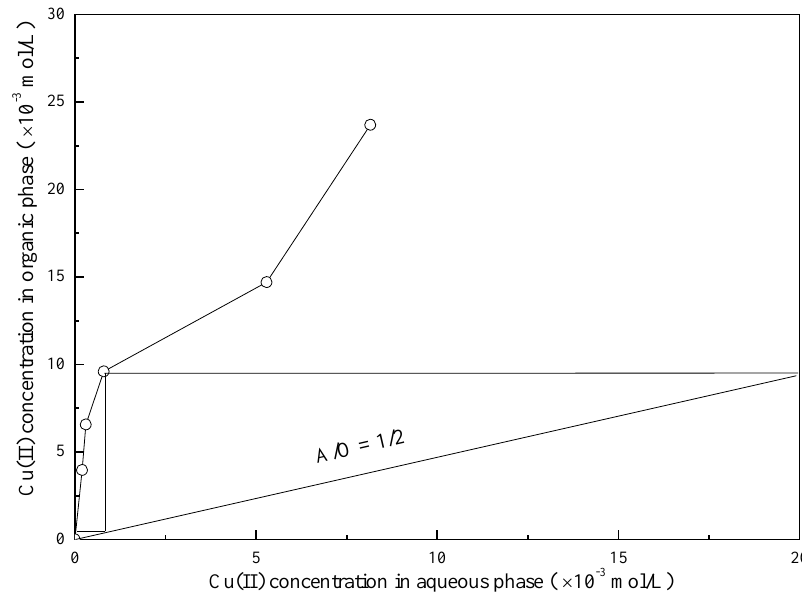
Figure 3. McCabe–Thiele plot for Cu(II) extraction using 2 mol/L LIX63. Figure 3. McCabe – Thiele plot for Cu(II) extraction using 2 mol/L LIX63. Based on the obtained results, a two-stage counter-current batch simulation test was performed at an A/O ratio of 1:2 and using 2 mol/L LIX63. The test results indicated that after the two-stage counter-current extraction, neither Cu(II) nor Ag(I) was detected in the raffinate, indicating that higher than 99.99% of Cu(II) and Ag(I) were co-extracted from the feed solution by using LIX63. The concentrations of Ni(II), Mg(II), and Al(III) after extraction were the same as those before